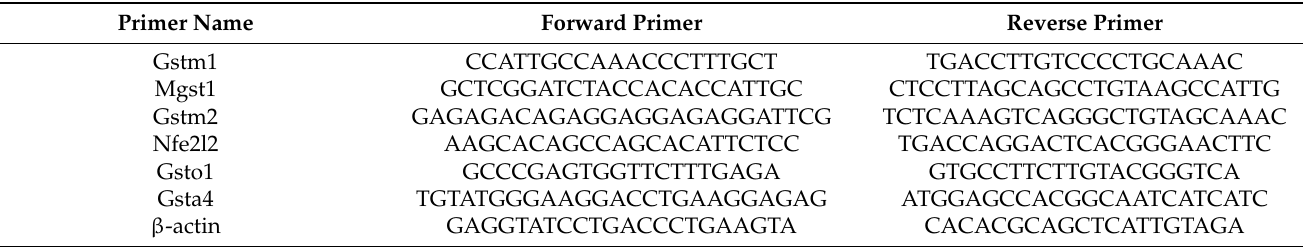
Table 2. qRT-PCR primers used in this